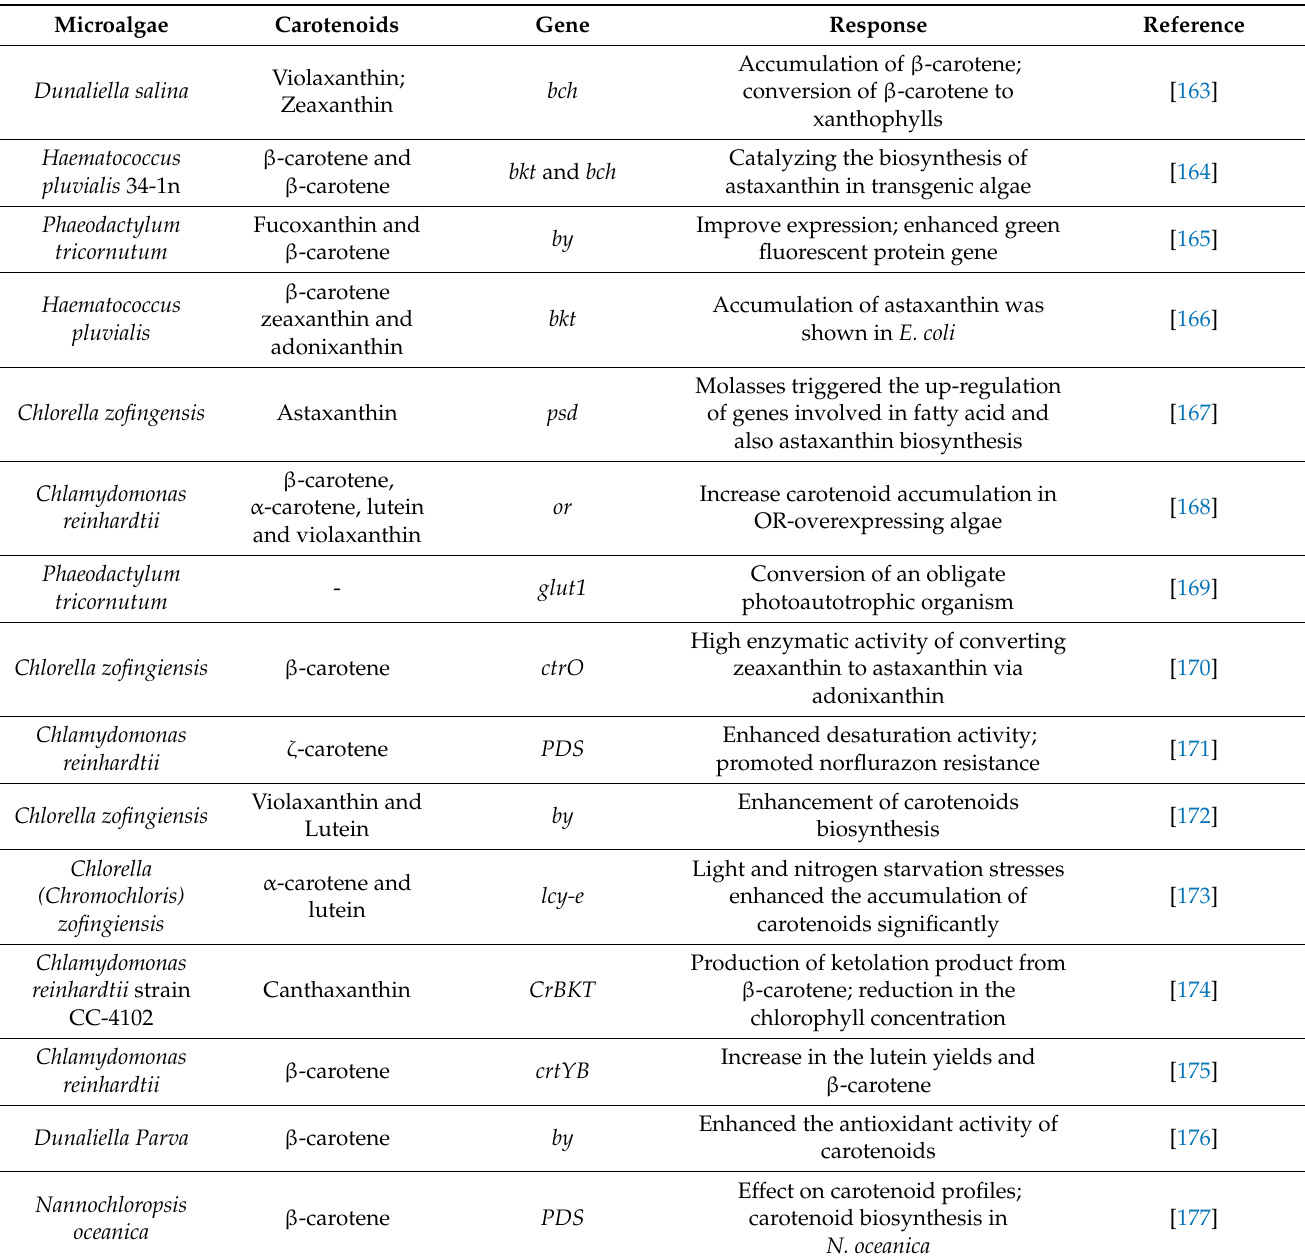
Table 3. Bioengineering approaches enhance the production of carotenoids by overexpression of the